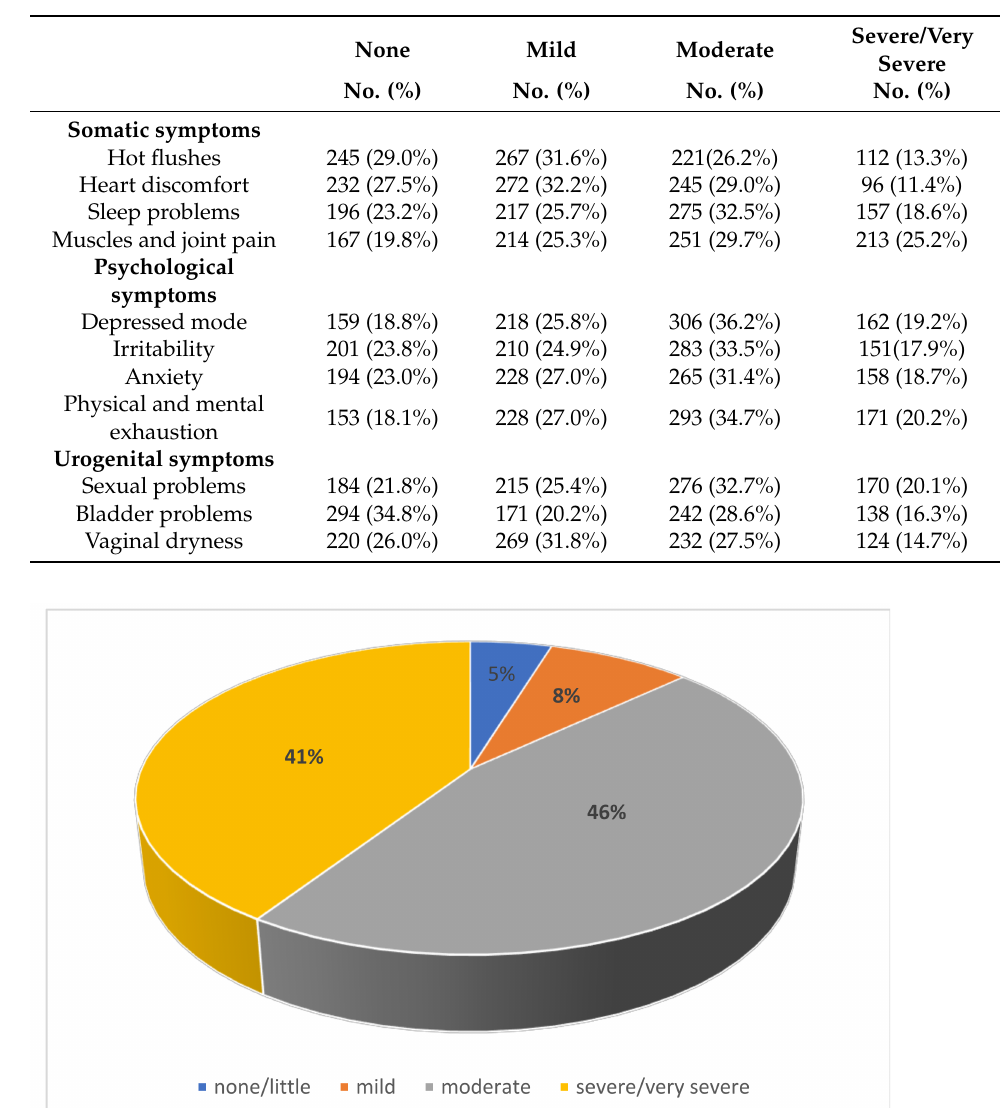
Table 2. Prevalence of postmenopausal symptoms among Saudi women attending different primary health centers.